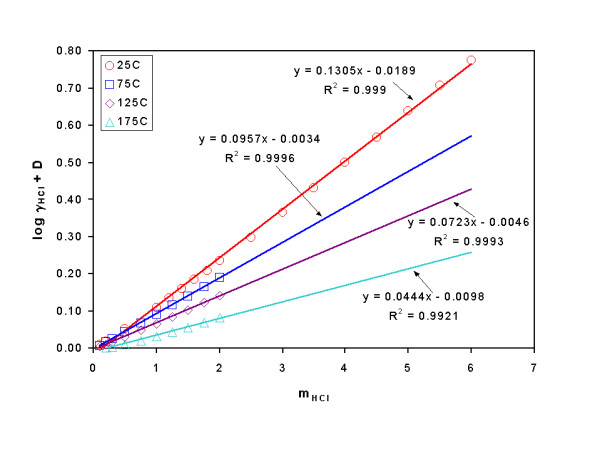
A plot of log γ±, HCl + D versus mHCl at 25°C, 75°C, 125°C and 175°C. The slope is the interaction coefficient ε(H+, Cl-).